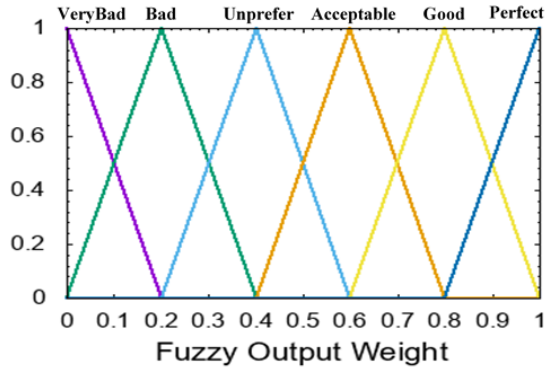
Figure 6. Fuzzy membership function plots for neighbor fuzzy